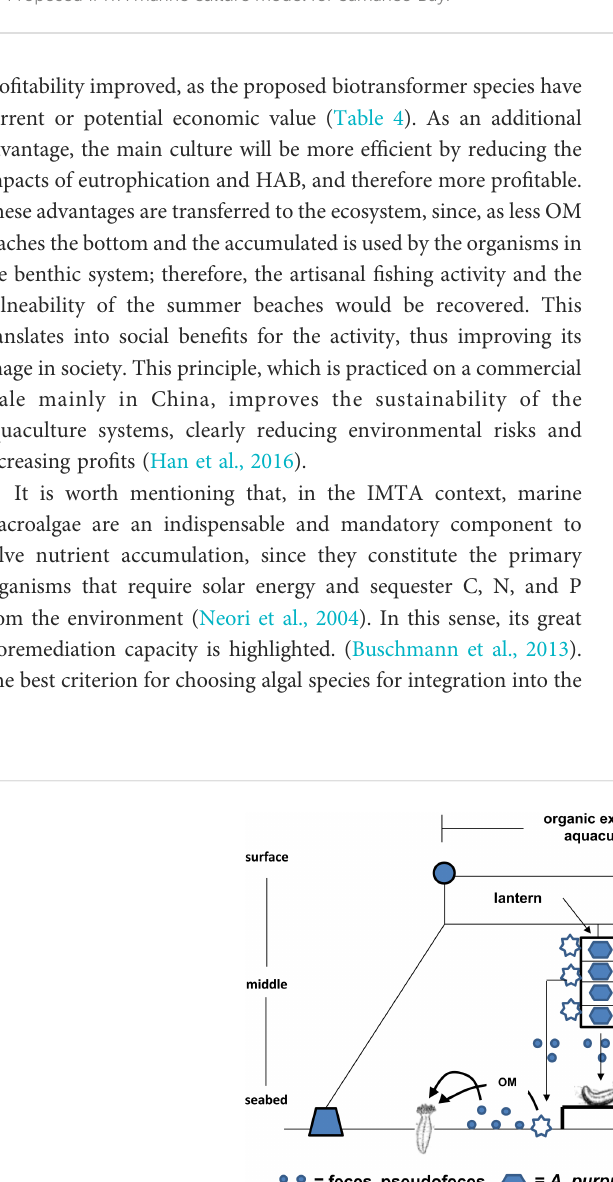
FIGURE 3 Proposed IMTA marine culture model for Samanco